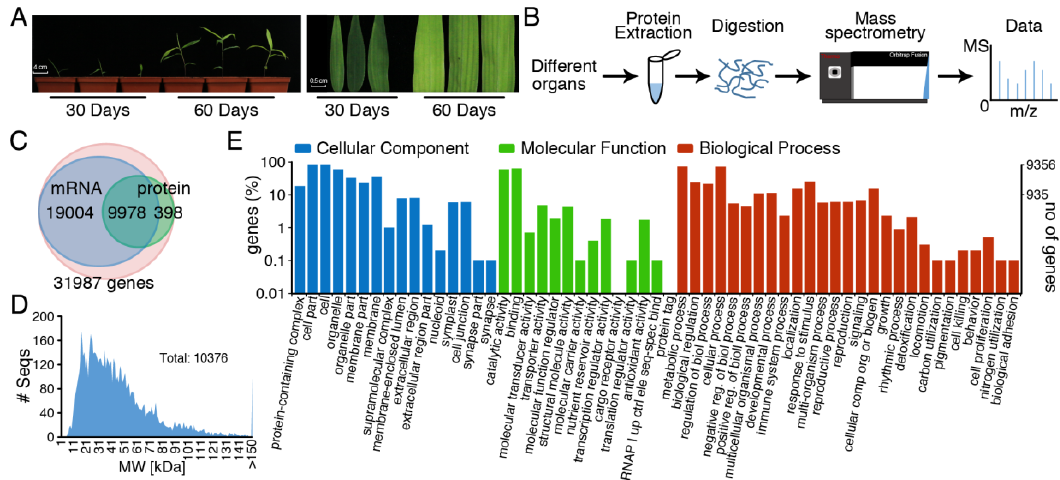
Figure 1. The flowchart of high-throughput label-free quantitative proteomics in moso bamboo. ( A ) The fully developed leaves of 30-days-old seedlings and 60-days-old moso bamboo were collected to detect the concentration and efficiency of protein extraction among different periods; ( B ) The pipeline of label-free quantitative proteomics; ( C ) Venn diagram of moso bamboo proteins and the mRNA transcription; ( D ) The distribution of molecular weight of moso bamboo proteins; ( E ) GO functional annotation of total proteins. Table 1. The comparative analysis of the efficiency of the protein extraction methods in seedlings and leaves of moso bamboo.